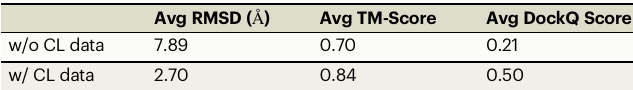
Table 1 | Average metric analysis for the top-scoring models with and without covalent labeling data. Source data are provided as a Source Data fi